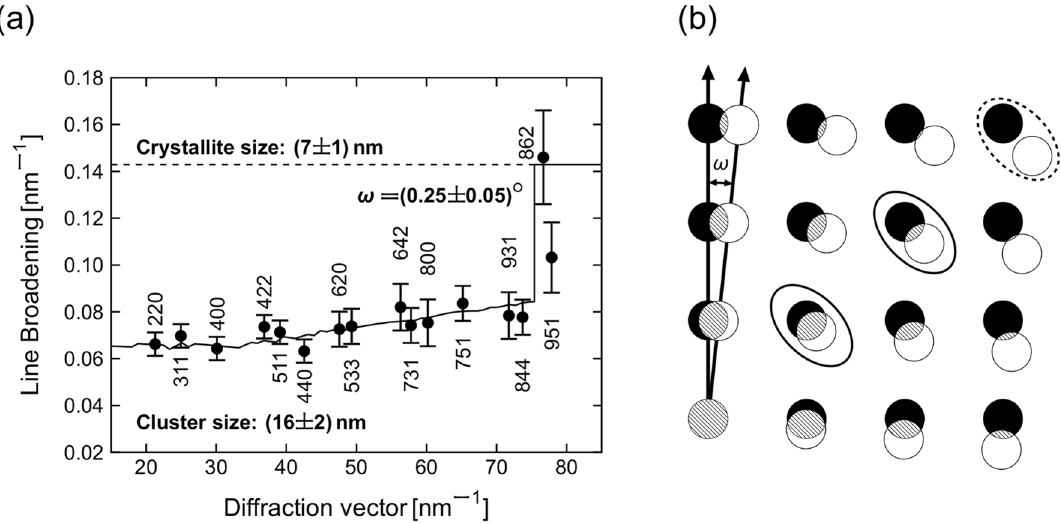
Figure 5. ( a ) Dependence of the XRD line broadening expressed in the reciprocal space units, FWHM ( rad ) cos θ/ (cid:31) , on the magnitude of the diffraction vector, · experimental data, the black solid line shows the dependence of the line broadening on partially coherent NCs according to Rafaja et al. 58 . ( b ) Schematic representation of the effect of the mutual misorientation of crystallites by the angle ω in direct space on the rotation of their reciprocal lattices, adapted from Rafaja et al. 59 . The reciprocal lattice points of two different crystallites are shown by filled and empty circles, respectively. The overlap of the reciprocal lattice points (hatched areas) represents the degree of partial coherence of the crystallites that decreases with their increasing distance from the origin of the reciprocal lattice 58,59 . Solid ellipses mark two examples of overlapping pairs of reciprocal lattice points. The dashed ellipse marks separated (non-coherent) reciprocal lattice